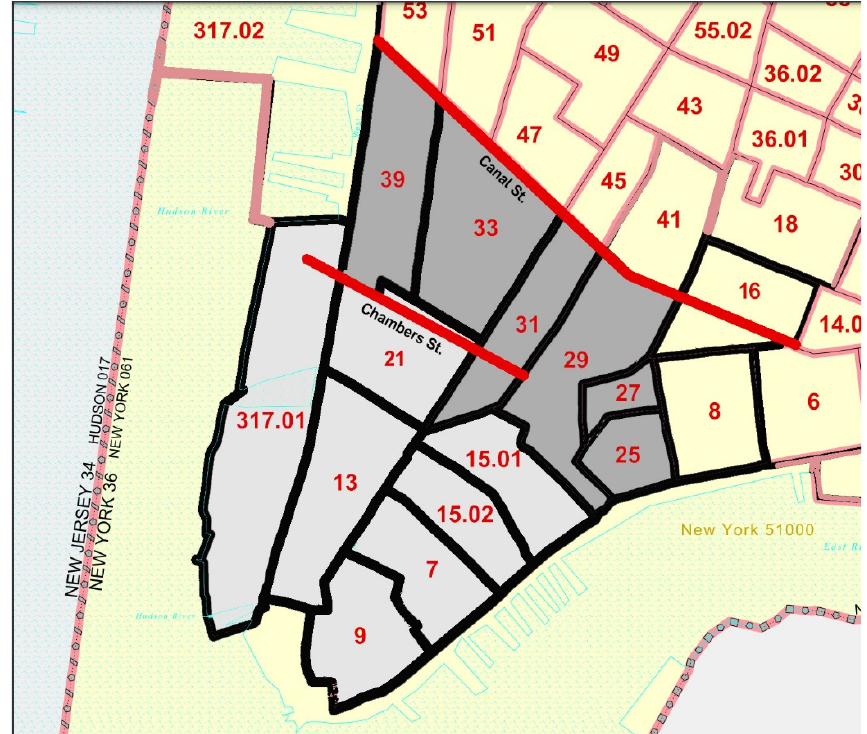
Figure 1. Census tract outline map for Lower Manhattan outlining census tracts for Group 1 and Group 2, New York City in 2000.